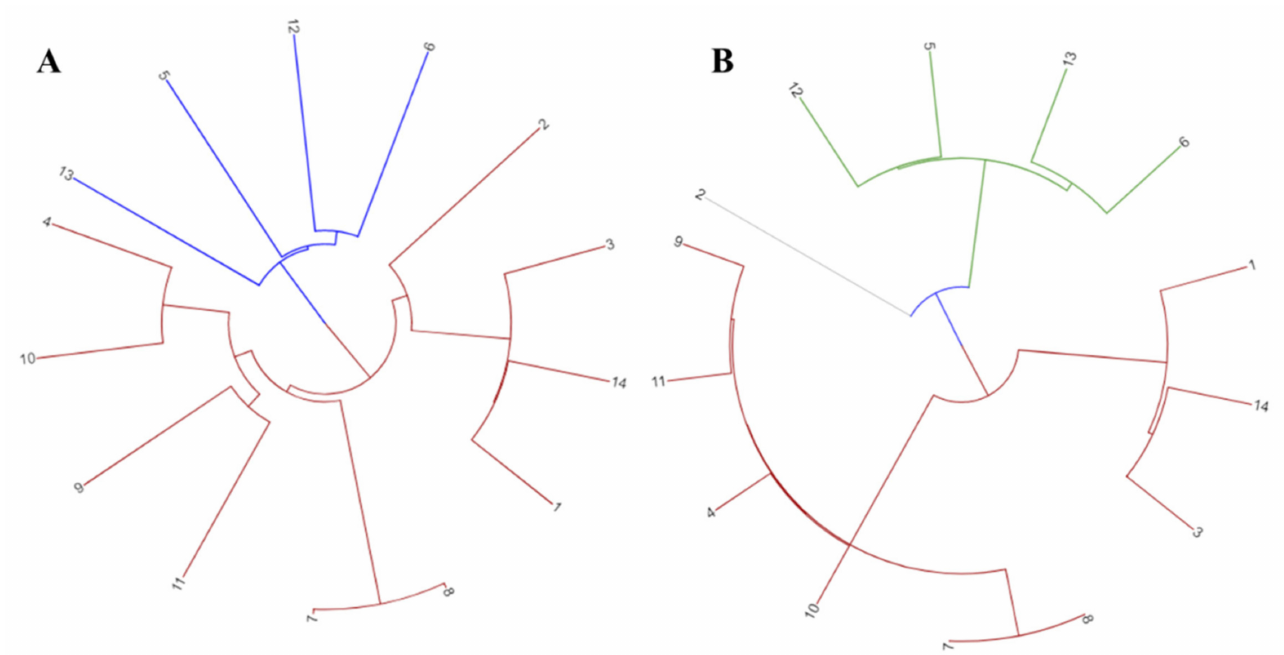
Figure 2. Phylogenetic tree depicting ( A ) Pan-genome phylogeny of 14 CRC related F. nucleatum strains used in this study ( B ) Core genome phylogeny of studied F. nucleatum strains. 1 = F. nucleatum CC53; 2 = F. nucleatum Fn10-CTX3; 3 = F. nucleatum Fn146CP; 4 = F. nucleatum Fn173CP; 5 = F. nucleatum Fn3760T; 6 = F. nucleatum FnS0431; 7 = F. nucleatum subsp. animalis strain P2_CP; 8 = F. nucleatum subsp. animalis strain P2_LM; 9 = F. nucleatum subsp. animalis strain THCT5A4; 10 = F.